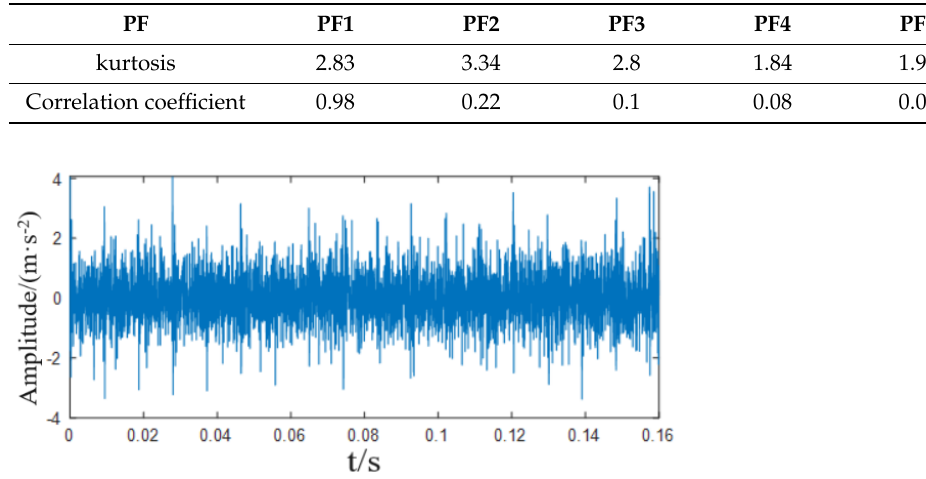
Figure 10. The components obtained after the RLMD decomposition of the experimental signal. Table 4. The kurtosis value from PF1-PF5 component and the correlation coefficient with the original signal.